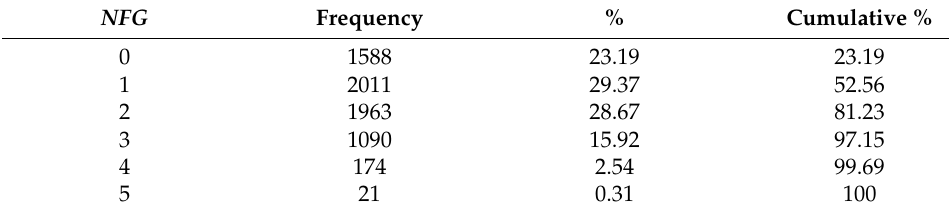
Table 3. Distribution of full known generations ( NFG ).